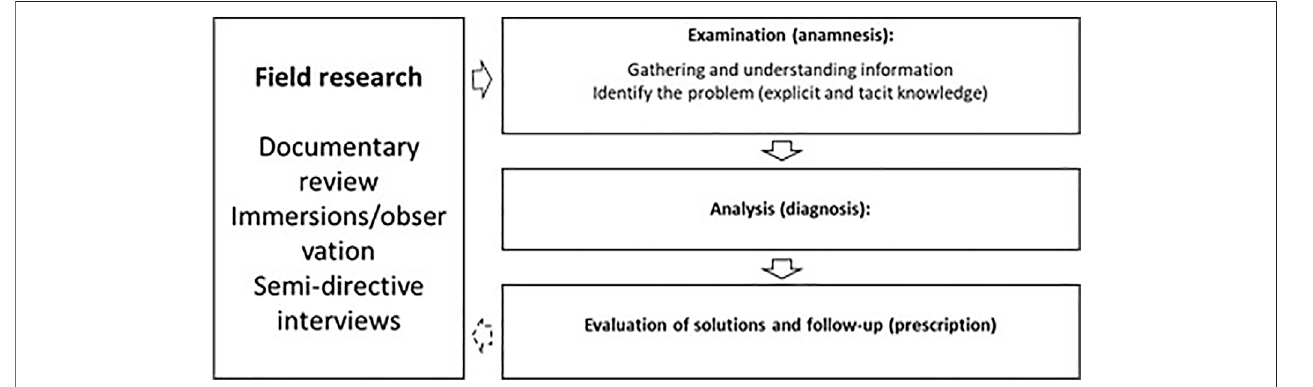
FIGURE 4 | Service Design methodology as a scienti fi c approach for evidence-based user experience